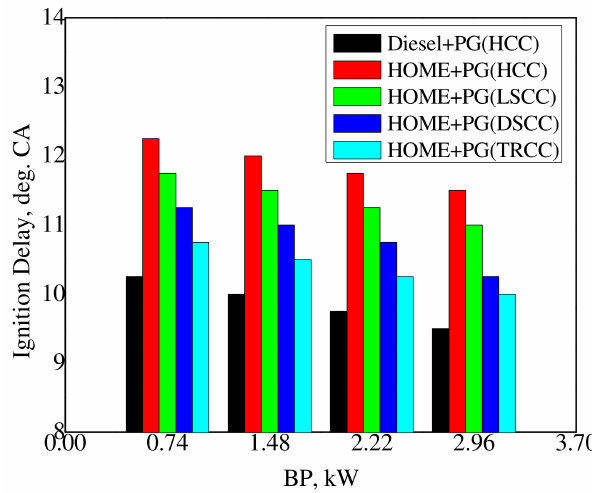
Figure 10. Effect of combustion chamber type on ignition delay.